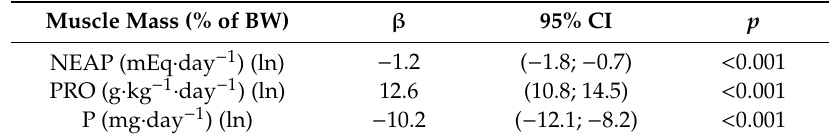
( − 12.1; − 8.2) < 0.001 Muscle mass (% of body weight) is estimated controlling for athlete sport and gender (adjusted for sports type and gender). F (5, 295) = 78.1, p < 0.0001, R 2 = 0.56. BW—body weight; NEAP—net endogenous acid production;